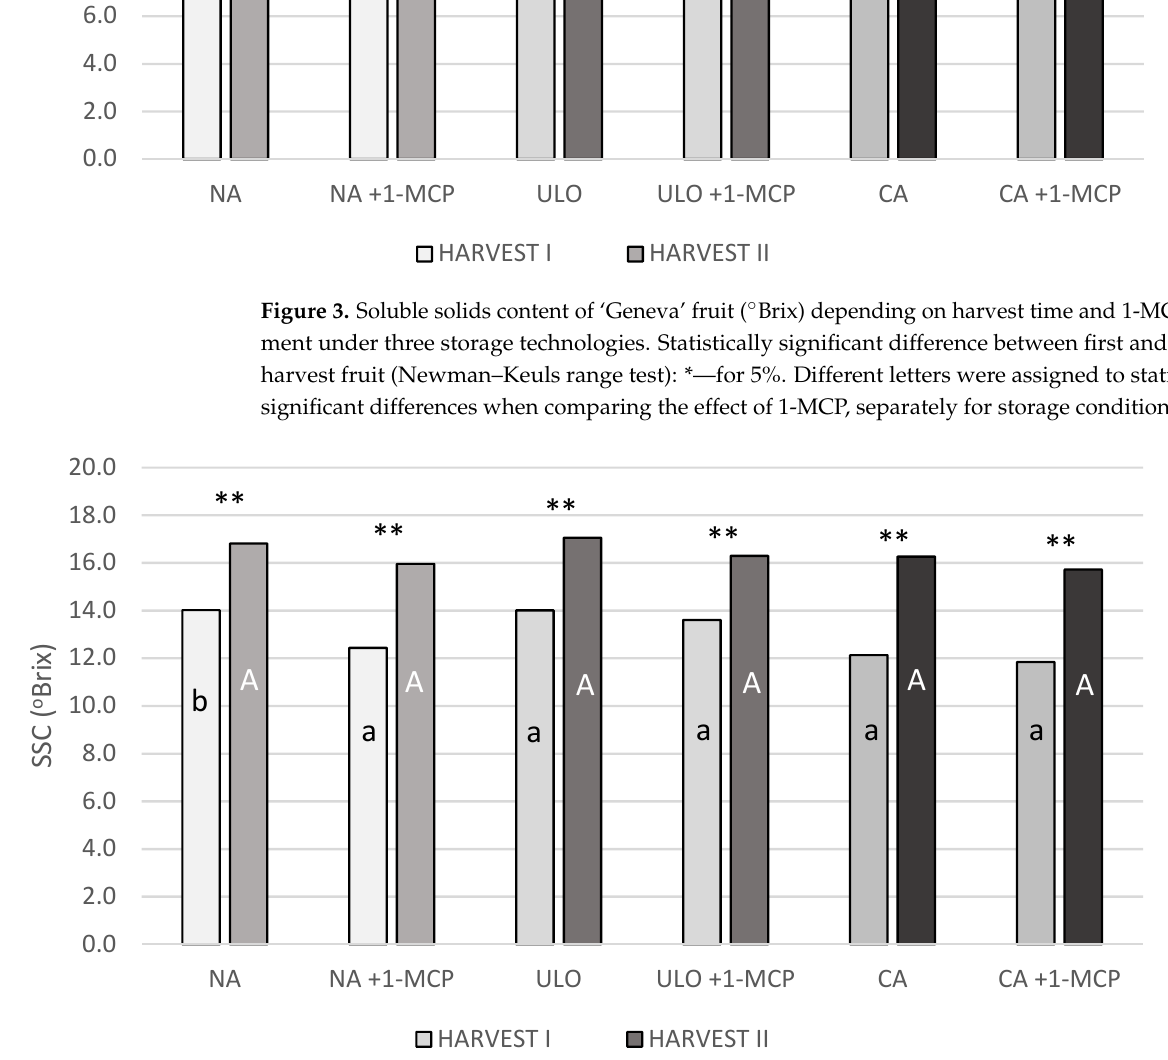
Figure 4. Soluble solids content of ‘Ananasnaya’ fruit ( ◦ Brix) depending on harvest time and 1-MCP treatment under three storage technologies. Statistically significant difference between first and second harvest fruit (Newman–Keuls range test): **—for 1%. Different letters were assigned to statistically significant differences when comparing the effect of 1-MCP, separately for storage conditions. Table 4. Changes of solids soluble content (°Brix) measured in ‘Geneva’ mini kiwi fruit in the post- harvest period.